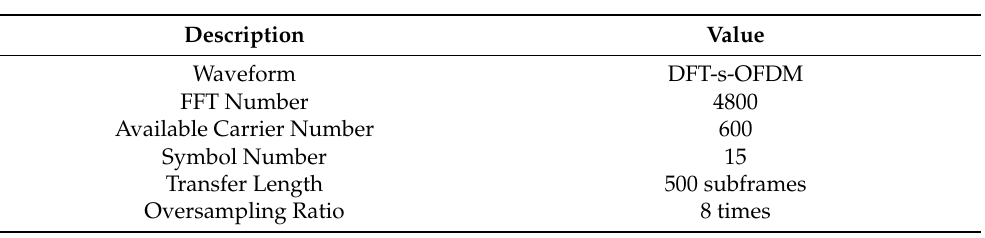
Table 3. Simulation parameter.